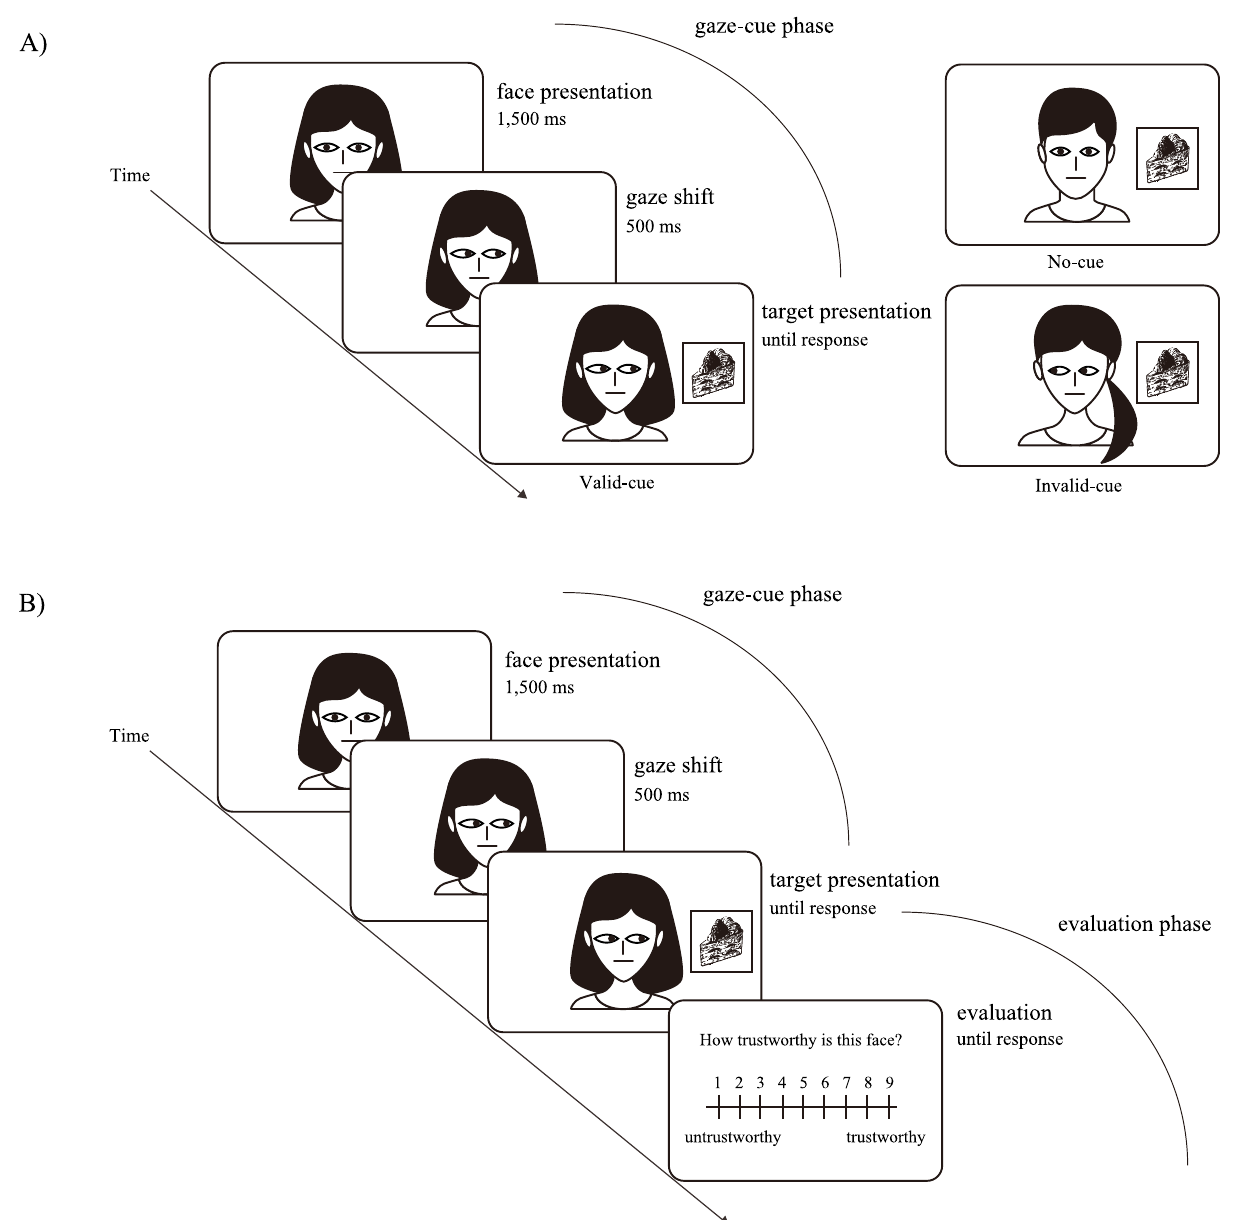
Fig 2. Each trial of the gaze cueing task. The faces and the targets in Fig 2 are not the original images that were used in our study, but schematic images used for illustrative purposes. (A) From one to five blocks of the gaze-cueing task only consist of the gaze-cue phase. (B) A final block consists of gaze-cue and evaluation